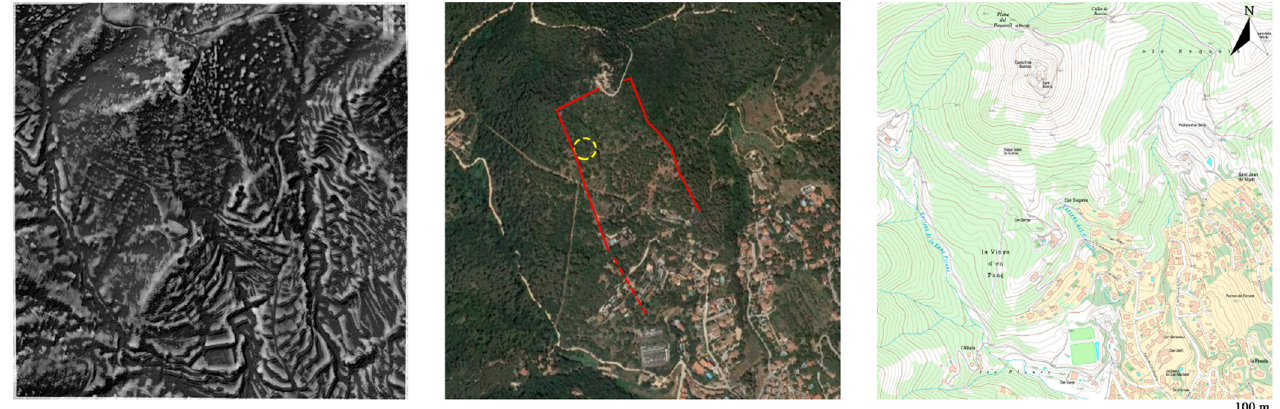
Figure 8. MSRM ( left ), satellite view ( centre ) and topographic map ( right, forest in green) of the Burriac site. In the satellite image the walls (red) and the known location of the settlement (yellow) are indicated.